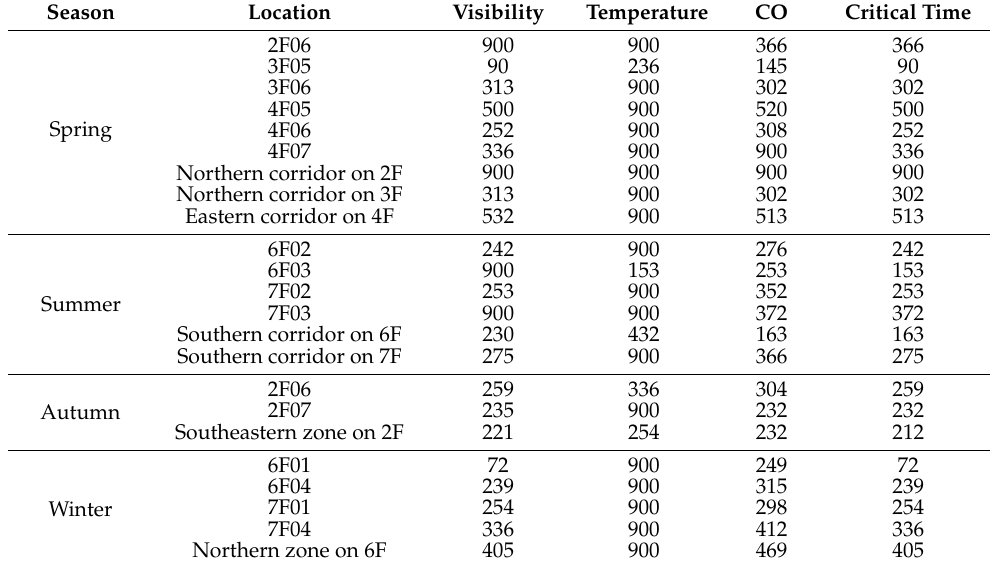
Table 8. Times taken to reach critical values of fire products in evacuation passageways (in